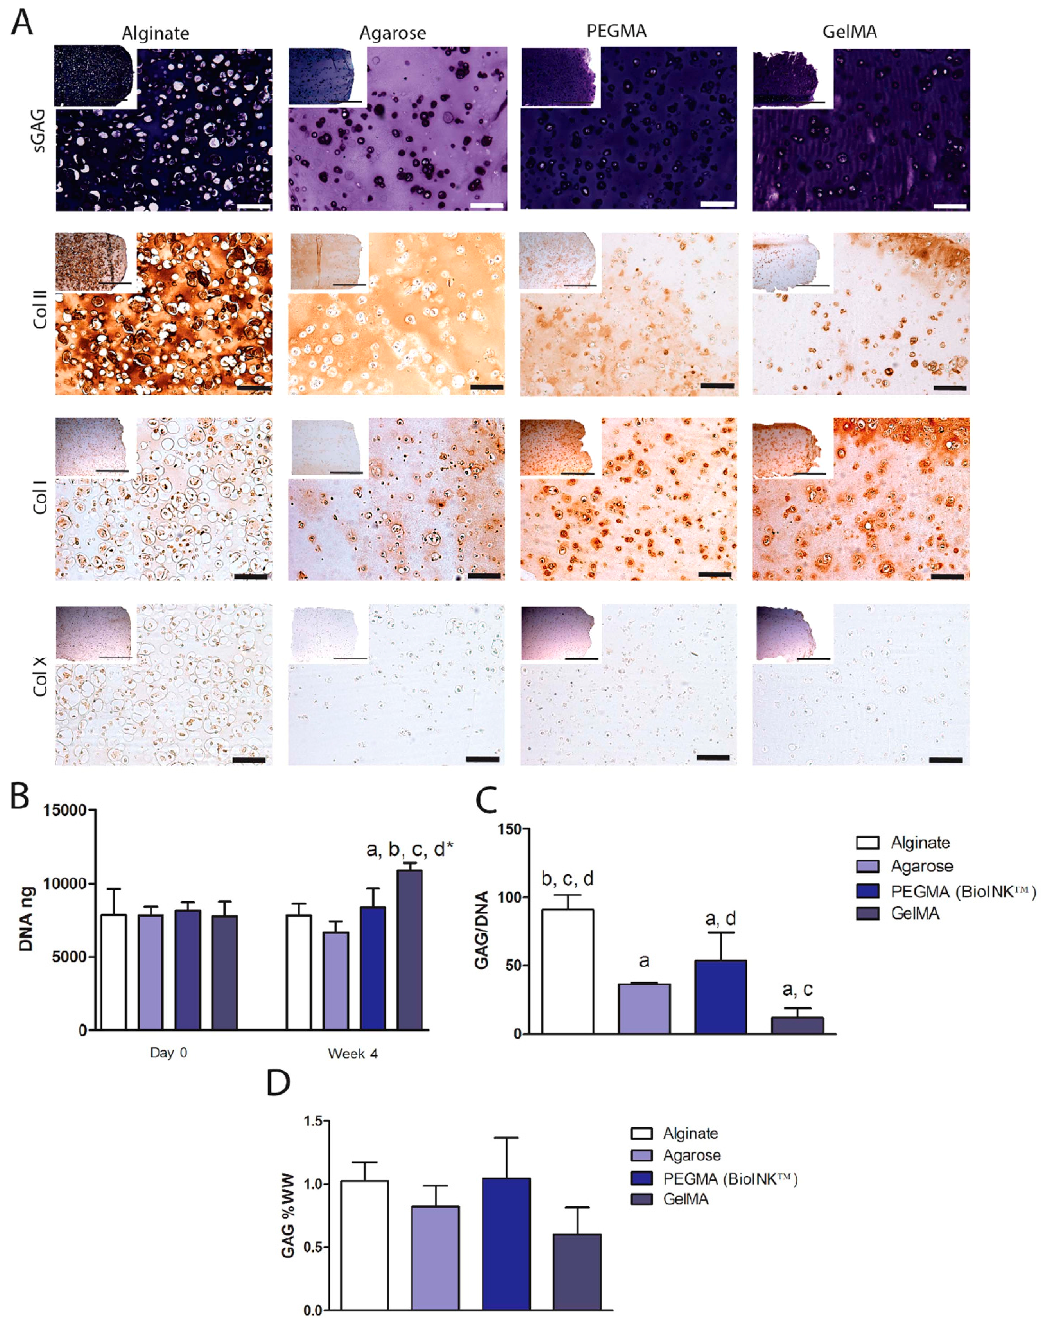
Figure 3. Regenerative ability of agarose-, alginate-, GelMA- and PEGMA-based hydrogels seeded with MSCs and cultured in a chondrogenic medium for four weeks. ( A ) Immunohistochemical and histological analyses showed that agarose and alginate both stained for collagen type II and glycosaminoglycans (GAG). In contrast, GelMA and PEGMA were more positive collagen type I; ( B ) DNA content (ng) quantification for each construct; ( C ) GAGs per DNA ratio; ( D ) Weight/weight GAG percent (%WW). Biochemical analyses showed that GelMA had the lowest GAG levels. Significance p < 0.05, (a) versus alginate at the same time point, (b) versus agarose, (c) versus PEGMA, (d) versus GelMA, (d*) versus GelMA at day 0 [88]. Reproduced with permission from IOP SCIENCE.